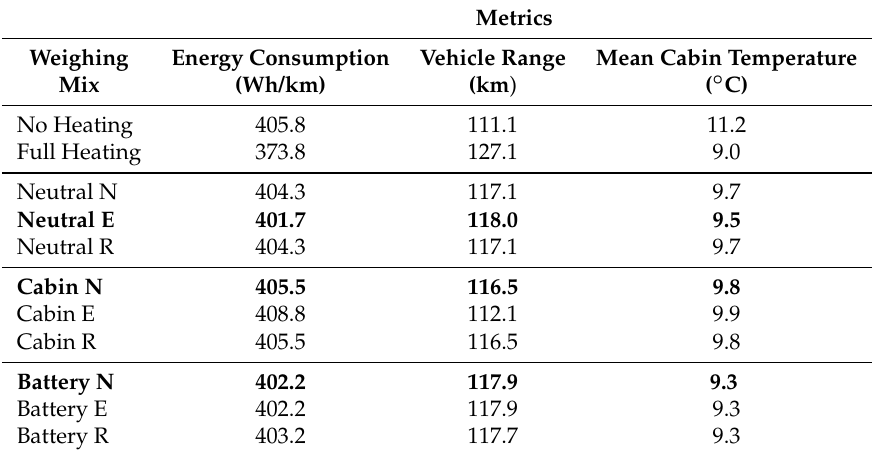
Table 8. Vehicle metrics corresponding to solutions from sensitivity testing performed at − 7 ◦ C. Here bold text indicates the most preferable outcome in the authors